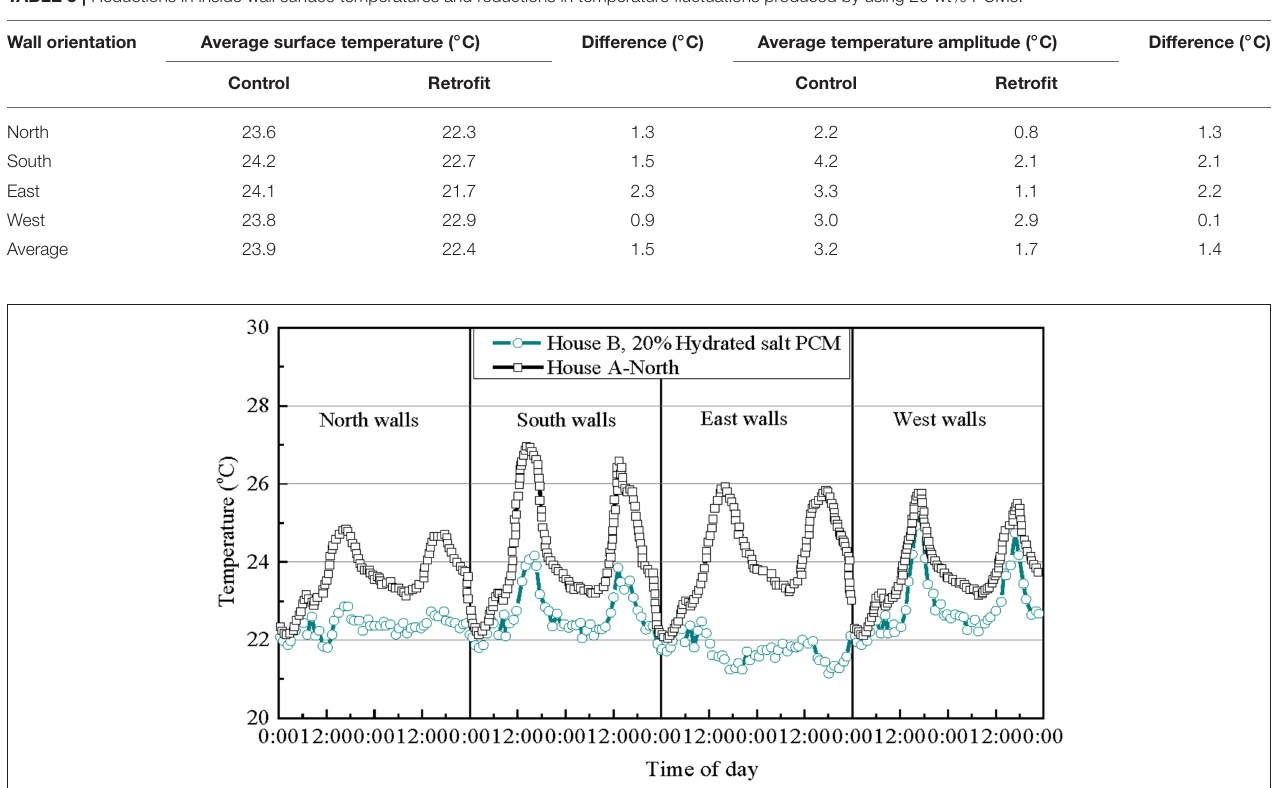
FIGURE 7 | North, south, east, and west walls inside surface temperatures using 20 wt%